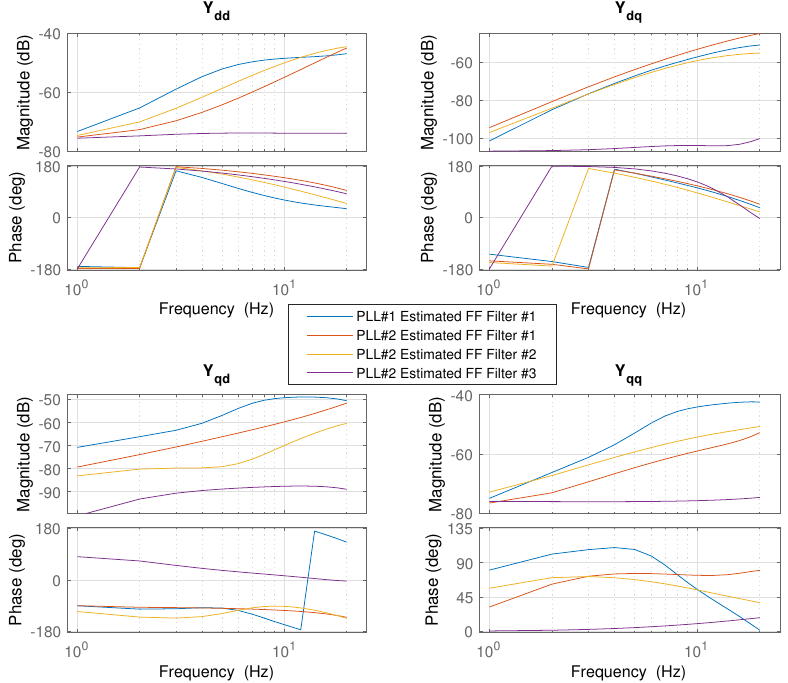
Figure 26. Traction chain input admittance. Frequency range: 1–20 Hz. Contact-line voltage filter